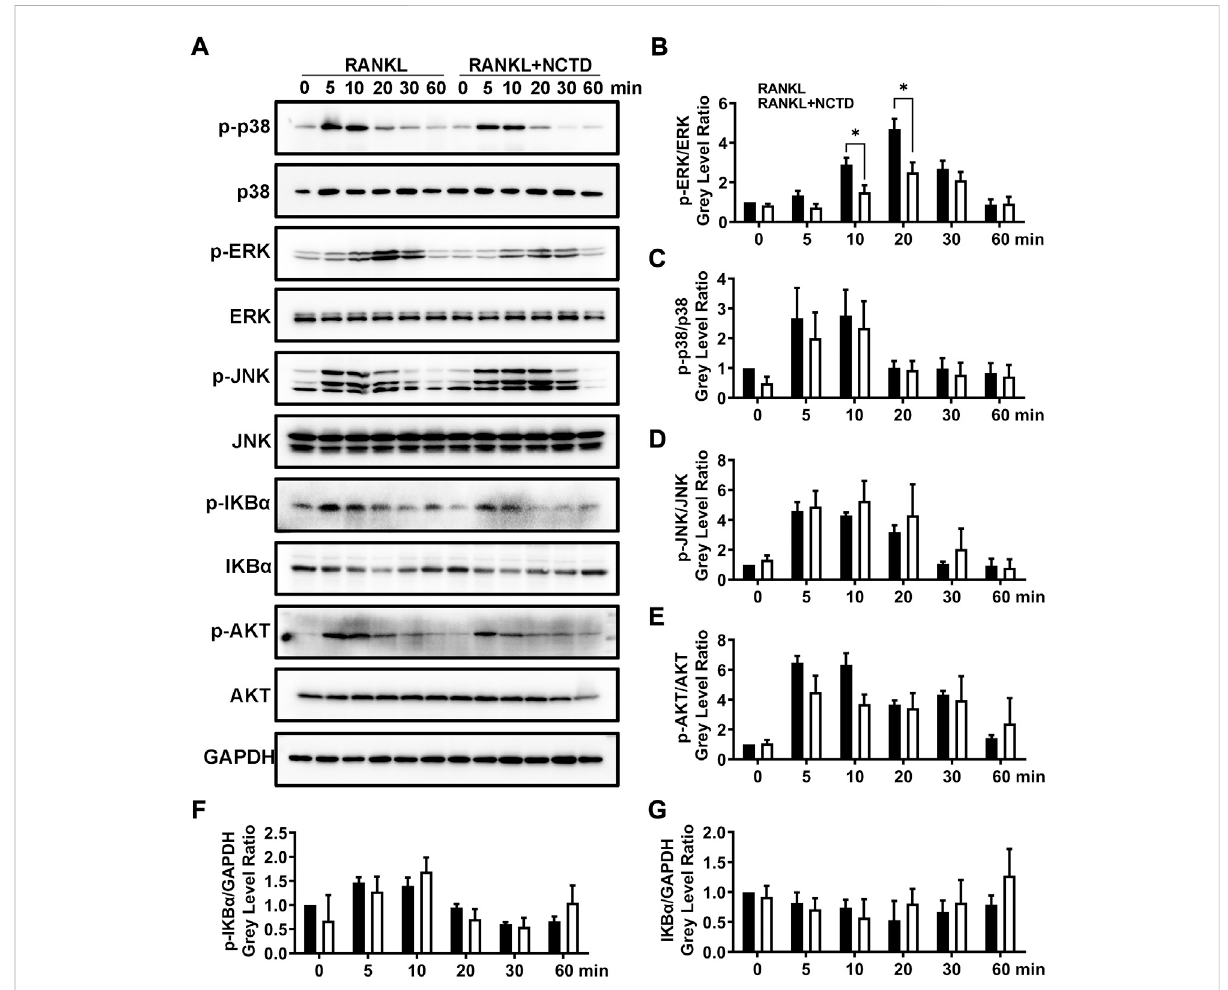
FIGURE 4 NCTDcandownregulatetheexpressionofERKinBMMcellsduringosteoclastformation. (A) Westernblottingwasusedtomeasurep-p38,p38, p-ERK, ERK, p-JNK, JNK, p-IKB α , IKB α , p-AKT, AKT and GAPDH expression level on BMMs after RANKL stimulating at 0, 5, 10, 20, 30 and 60 min. (B) The phosphorylation degree of p-ERK can be showed by the p-ERK /ERK gray value ratio in Western blotting. (C) Western blotting bands of P-P38/ P38 were quanti fi ed. (D) The phosphorylation degree of P-JNK can be showed by the p-JNK/JNK gray value ratio in Western blotting. (E) The phosphorylation degree of P-AKT can be showed by the p-AKT/AKT gray value ratio in Western blotting. (F) The Western blotting bands of P-IKB α / GAPDH were quanti fi ed and represented by histograms. (G) The Western blotting bands of IKB α /GAPDH were quanti fi ed. All experiments were repeated independently for three times. Values are expressed as mean ± SD; * p < 0.05, ** p < 0.01 vs. the control